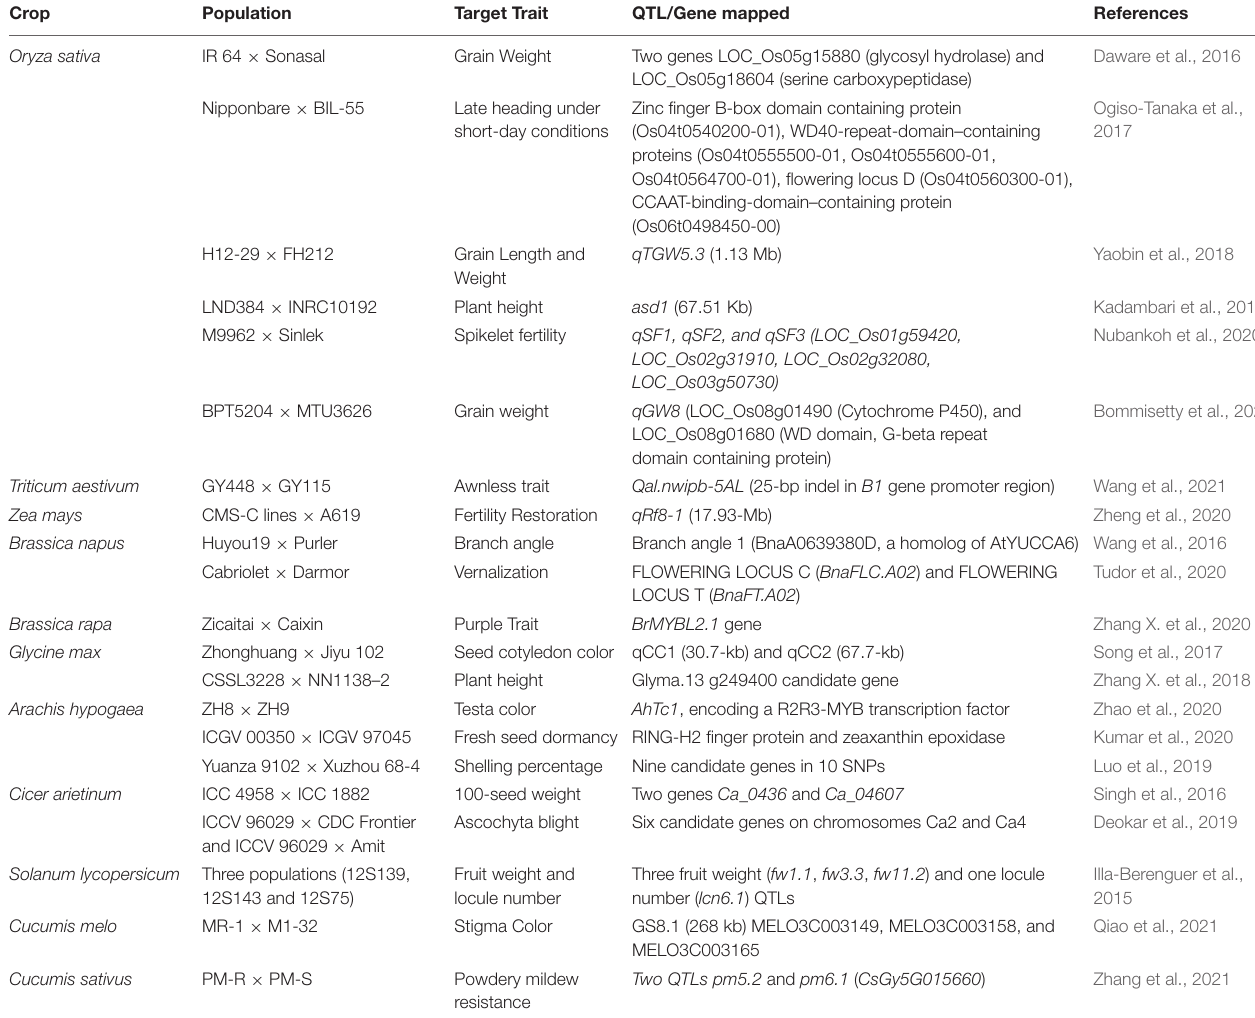
TABLE 2 | List of important QTL-seq studies in crop